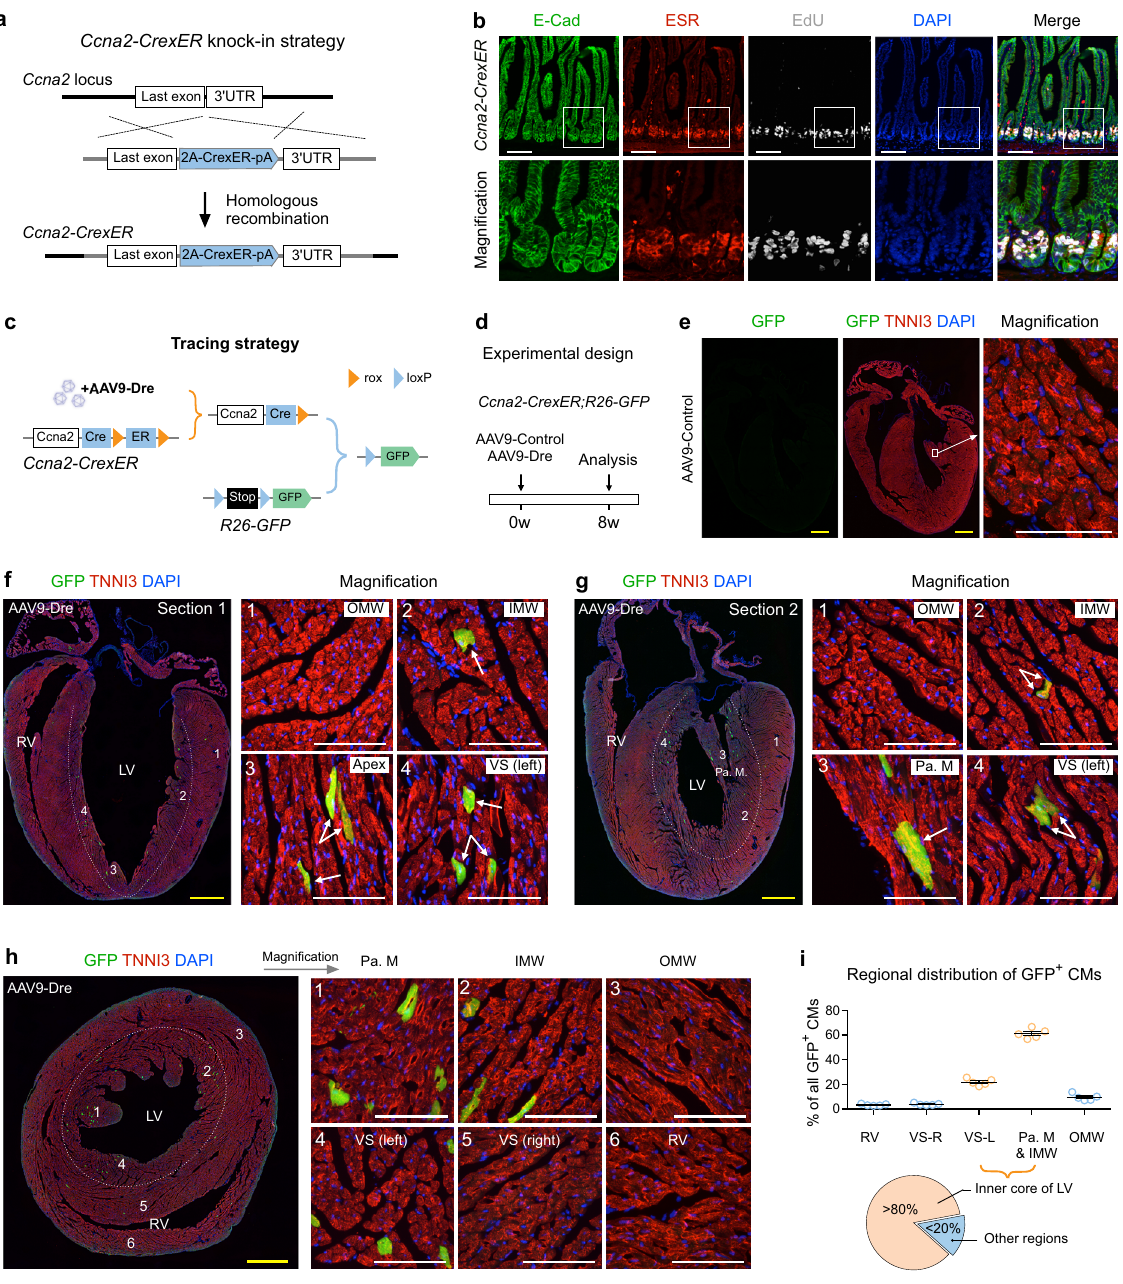
Fig. 5 Cyclin A2 ( Ccna2 ) based ProTracer reveals a highly regional pattern of cardiomyocyte cell-cycle activity. a Schematic showing generation of a Ccna2-CrexER knock-in allele. b Immunostaining for E-Cad, ESR, and EdU on intestinal sections from adult (10 weeks old) Ccna2-CrexER mice. Mice received intraperitoneal EdU injection and were sacri fi ced 3 h afterward for analysis. c Schematic showing AAV9-Dre induced genetic tracing of Ccna2 + cardiomyocytes. d Schematic of the experimental design. e Immunostaining for GFP and TNNI3 on heart sections prepared from AAV9-control-treated mice. f , g Immunostaining for GFP and TNNI3 on heart sections from AAV9-Dre treated mice. Numbered regions (1,2,3,4) are magni fi ed on the right. Arrows, GFP + cardiomyocytes. h Immunostaining for GFP and TNNI3 in transverse heart sections. The dotted line demarcates the inner core region of the LV that harbors the majority of GFP + cardiomyocytes. Numbered regions (1 – 6) are magni fi ed on the right. i Quanti fi cation of the distribution of GFP + CMs in different regions of the ventricles. Data are the mean ± s.e.m.; n = 5. Scale bars: yellow, 1 mm; white, 100 µ m. Each image is representative of fi ve individual biological